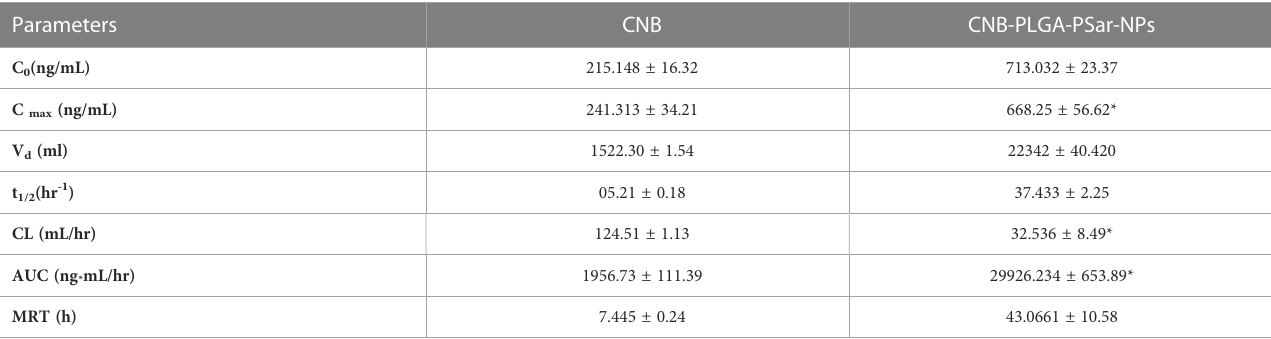
TABLE 1 Pharmacokinetic parameters Cabozantinib (CNB), CNB-PLGA-PSar-NPs after intravenous administration of 20 mg/kg dose.